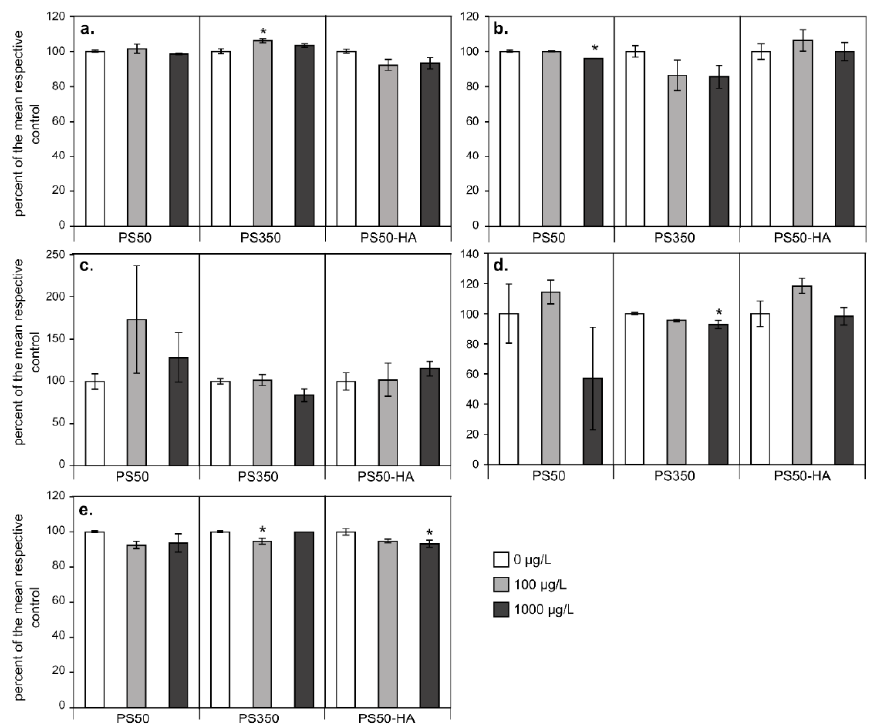
Figure 3. PSII yield expressed as percentages of the control after 96 h of exposure to PS50, PS350 and PS50-HA for the algae Nitzschia palea ( a ), Gomphonema parvulum ( b ), Nostoc sp. ( c ), Komvophoron sp. ( d ) and Scendesmus obliquus ( e ). Mean ± SE (n = 4), asterisks correspond to data significantly different from the corresponding control (*: p < 0.05).